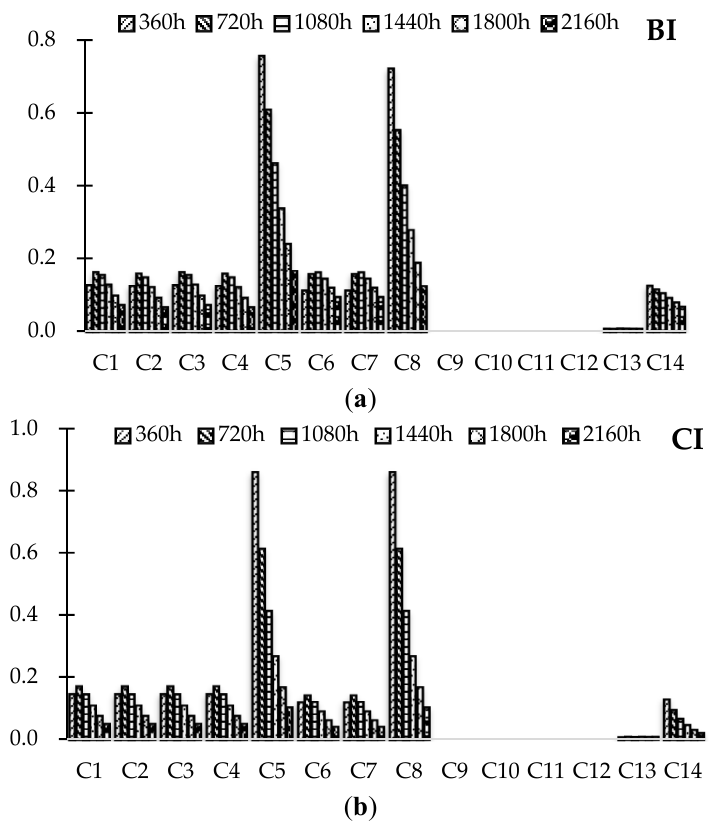
Figure 6. Birnbaum Importance (BI) and Criticality Importance (CI) values for the system components when P N equals 0.